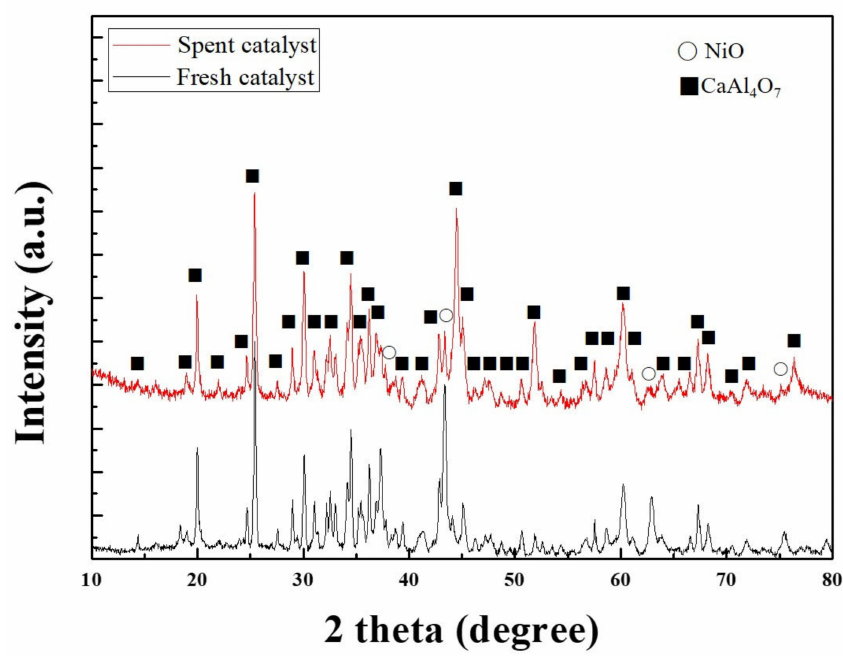
Figure 5. Powder X-ray di ff raction (XRD) patterns of the fresh and spent